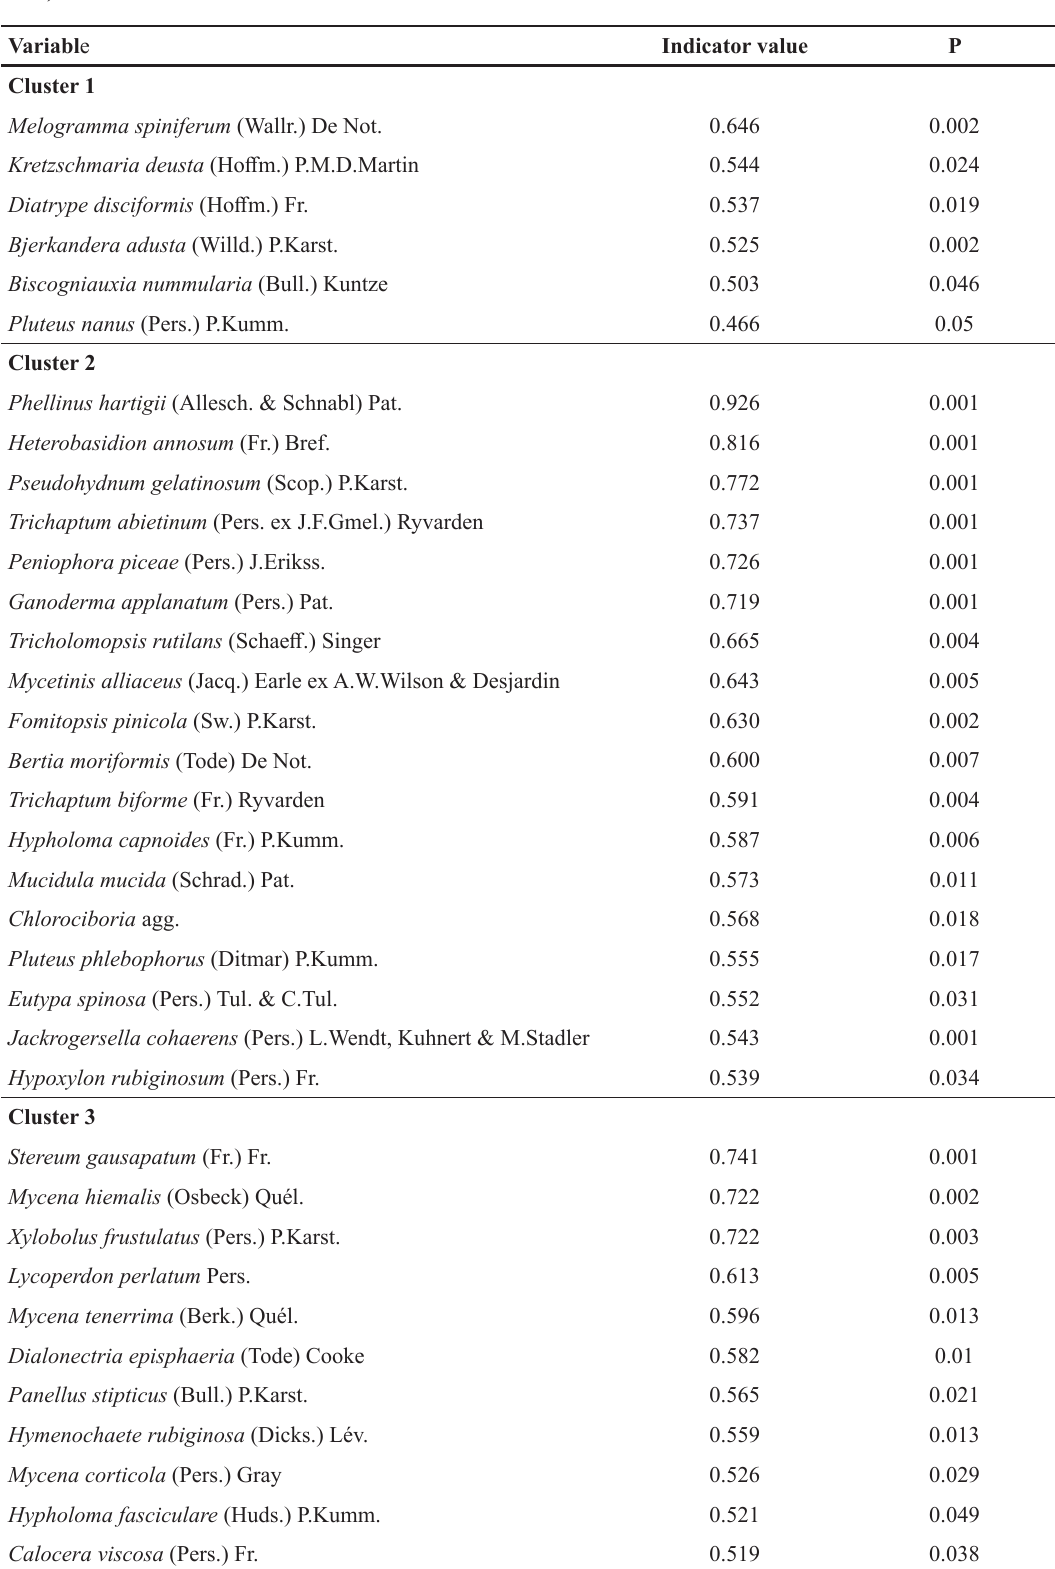
Table 2 – Diagnostic species (significantly associated to the clusters resulting from hierarchical clustering, with indicator values and P-values <